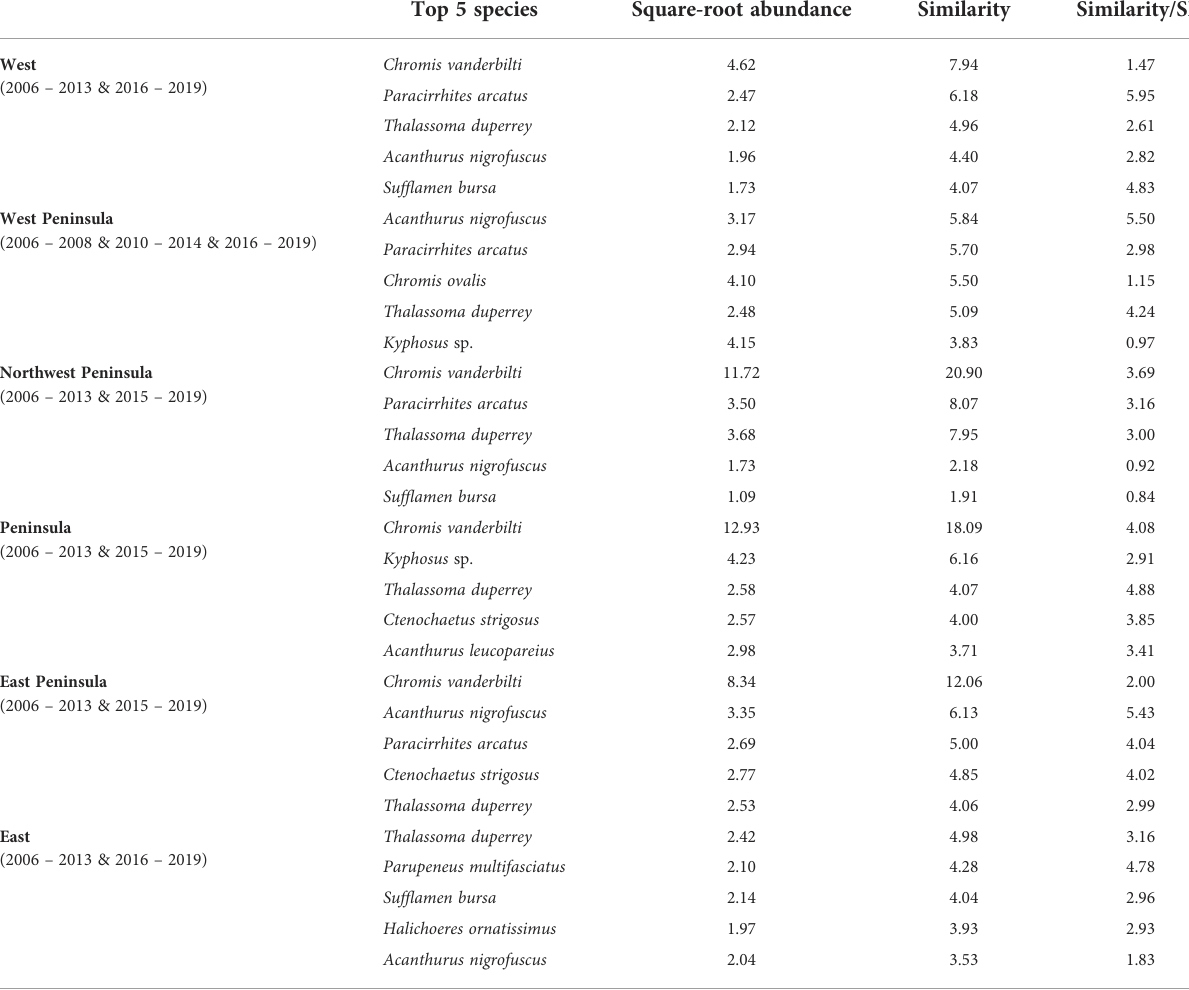
TABLE 4 Results of SIMPER analysis showing the top fi ve species that were consistently present in high abundance in each region of KALA in “ typical ” years identi fi ed by